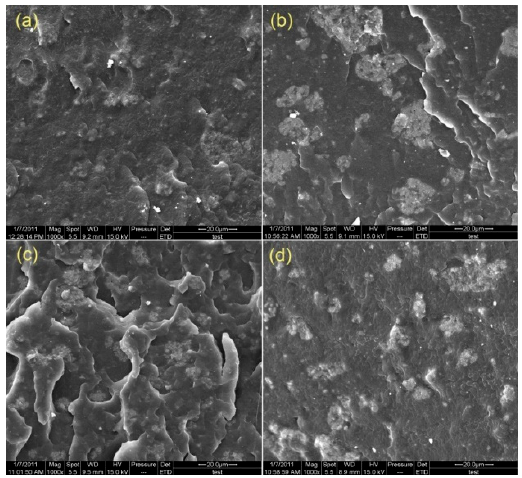
Figure 8. SEM images (1000×) of fractured surfaces for all the composites with 20 wt. % LDH. ( a ) S–